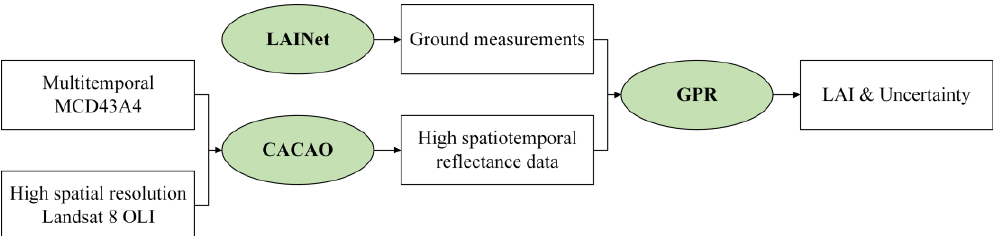
Figure 3. Flowchart of the methodology combining LAINet, CACAO, and GPR for the generation of LAI and uncertainty maps with high spatiotemporal